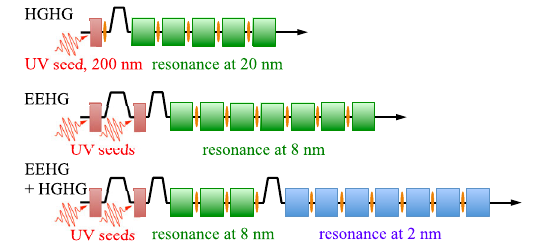
FIG. 3. Beam line layouts using HGHG, EEHG, and a combination of both. The thin ellipses indicate quadrupoles.